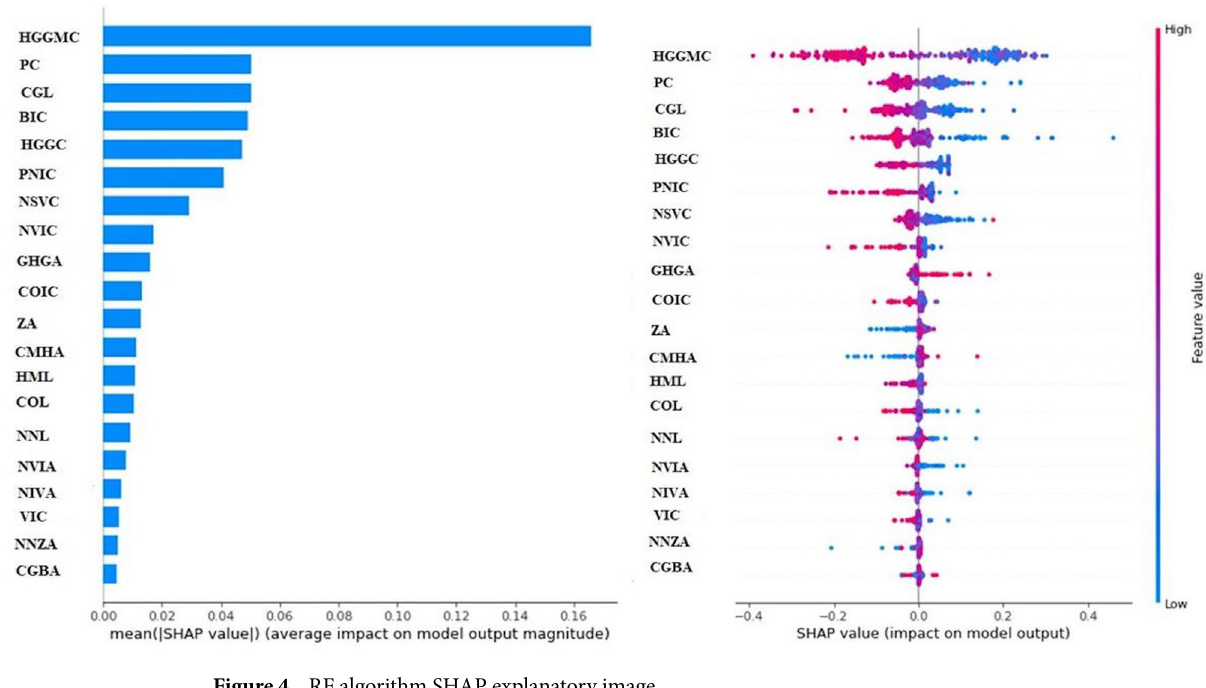
Figure 4. RF algorithm SHAP explanatory image.